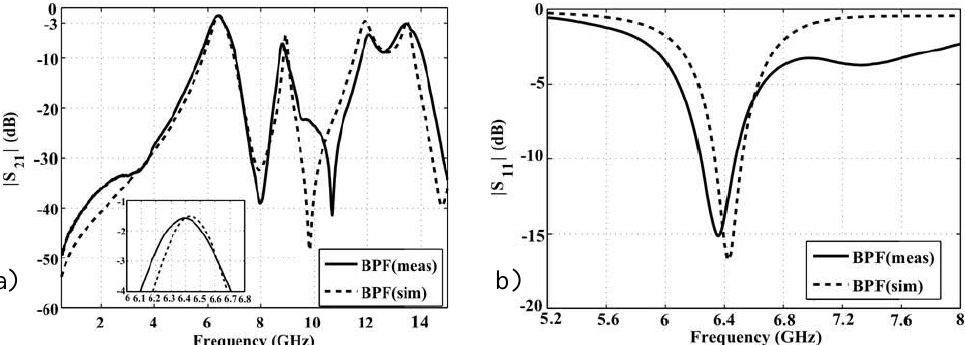
Figure 3. ( a ) Simulation vs . measurement: Transmission coefficient of the BPF; ( b ) Simulation vs . measurement: Reflection coefficient of the